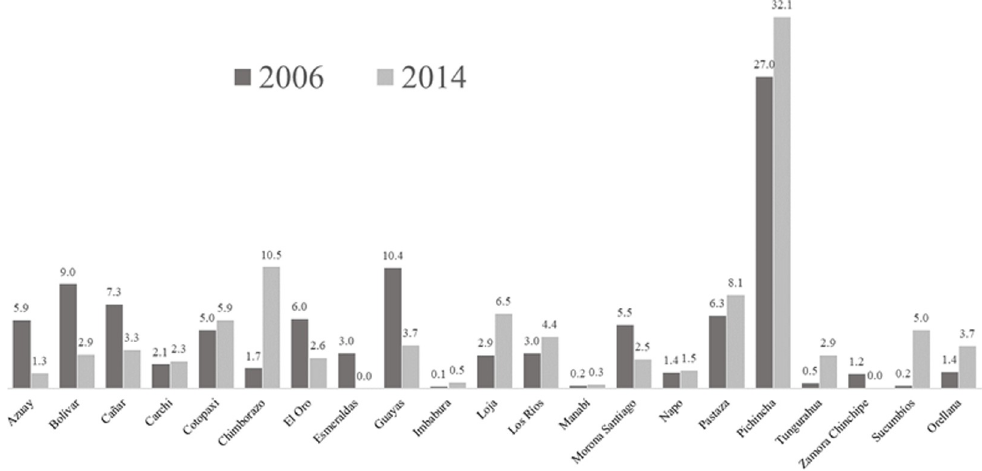
Fig 4. Provincial contribution to educational development overall inequality